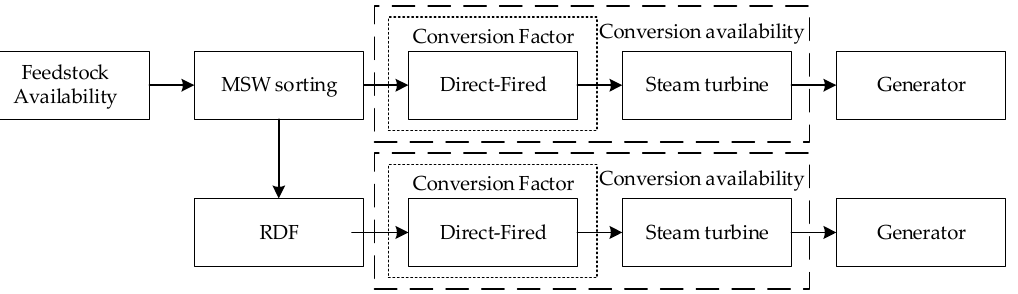
Figure 16. Basic operation model of MSW generation.